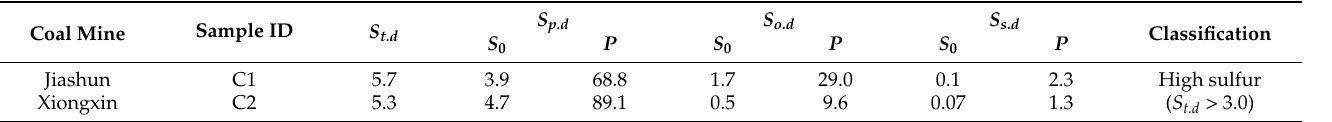
Table 1. Sulfur content in coal samples, wt%.